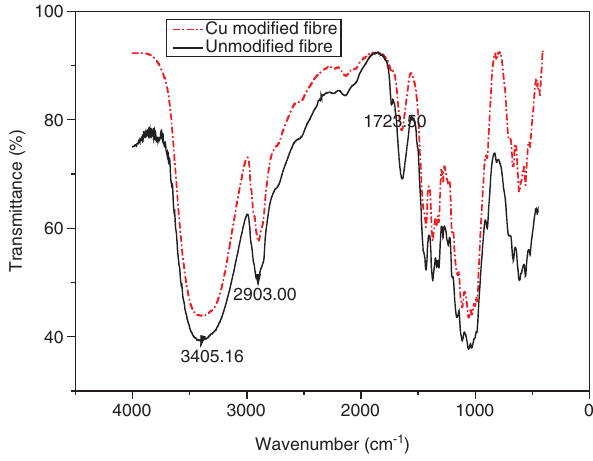
Figure 7: FTIR spectrum of unmodified and modified flax fiber.